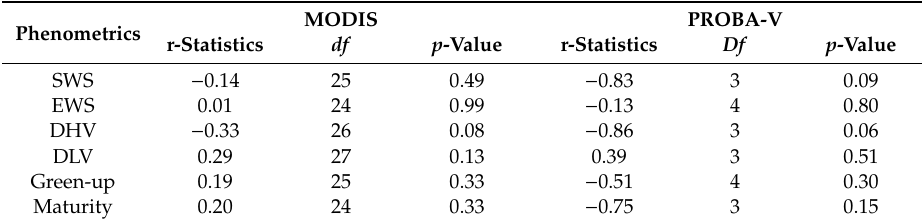
Table 4. Descriptors from the test comparing slopes from 1 of the relationship of phenometrics derived from satellite (MODIS and PROBA-V) and near-surface observations. In all models, each satellite sensor was analyzed as a predicted variable. The value df represents the degrees of freedom, SWS and EWS represent the start and the end of the wet season, and DHV and DLV represent the day of the highest and lowest values of